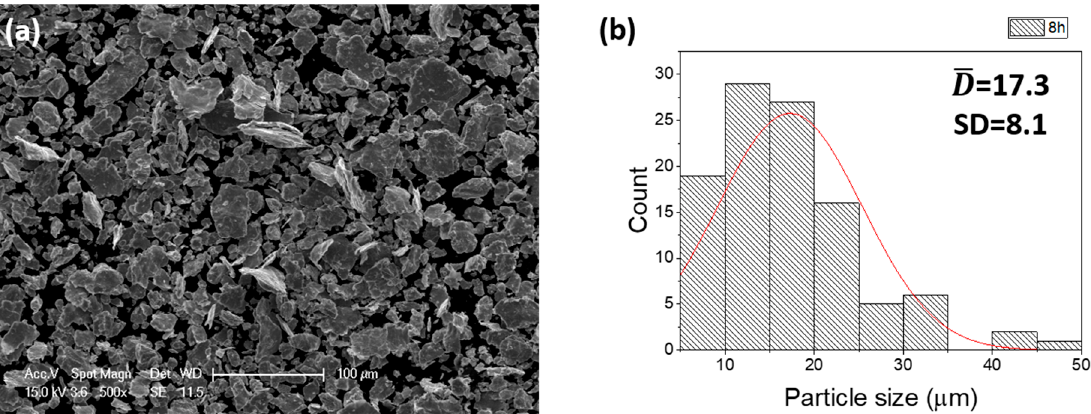
Figure 1. SEM image of powder resulting from 8 h of milling ( a ) and corresponding histogram illustrating particle size distribution ( b ).